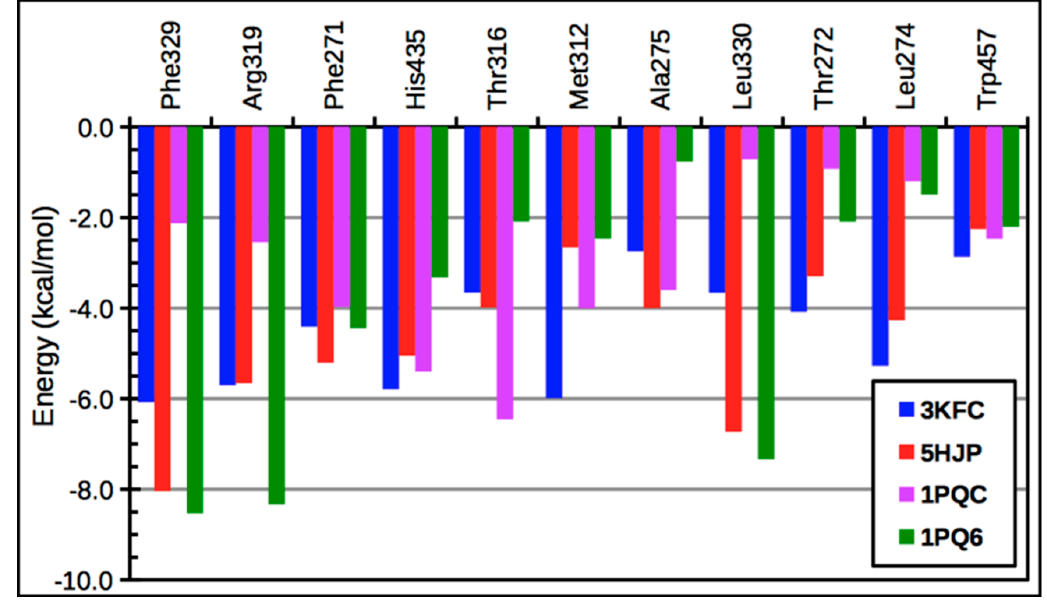
Figure 12. Interaction energies of 11 selected amino acids with ligands in the binding pocket of LXR β .